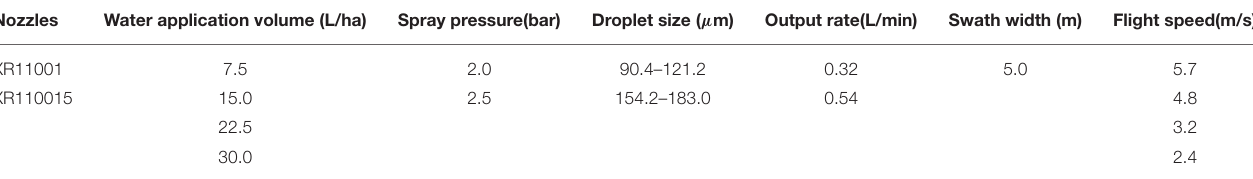
TABLE 1 | The speed of flight under different water application volumes. Nozzles Water application volume